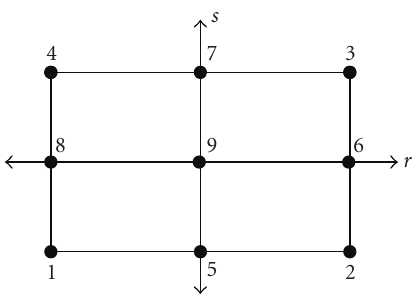
Figure 3.2 . The order of the nodes of a finite element defined on [ − 1,1] × [ −